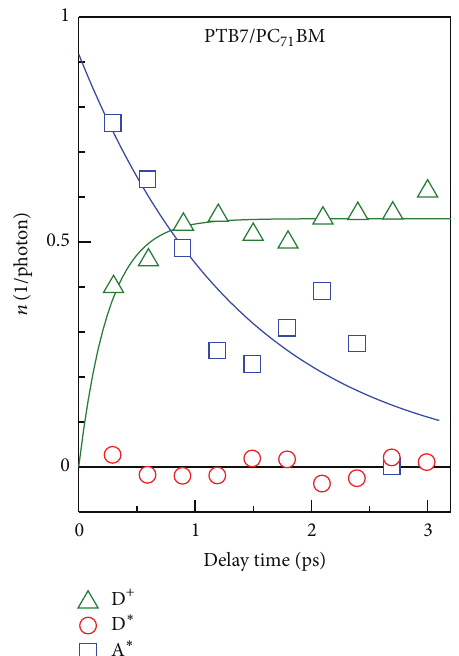
Figure 8: Absolute number of carriers ( 𝑛 D + ), donor excitons ( 𝑛 D ∗ ), and acceptor excitons ( 𝑛 A ∗ ) per an absorbed photon against the delay time in PTB7/PC 71 BM blend film. Adjacent averages were plotted in 𝑛 A ∗ . The solid curves are results of the least-squares fittings with exponential functions.